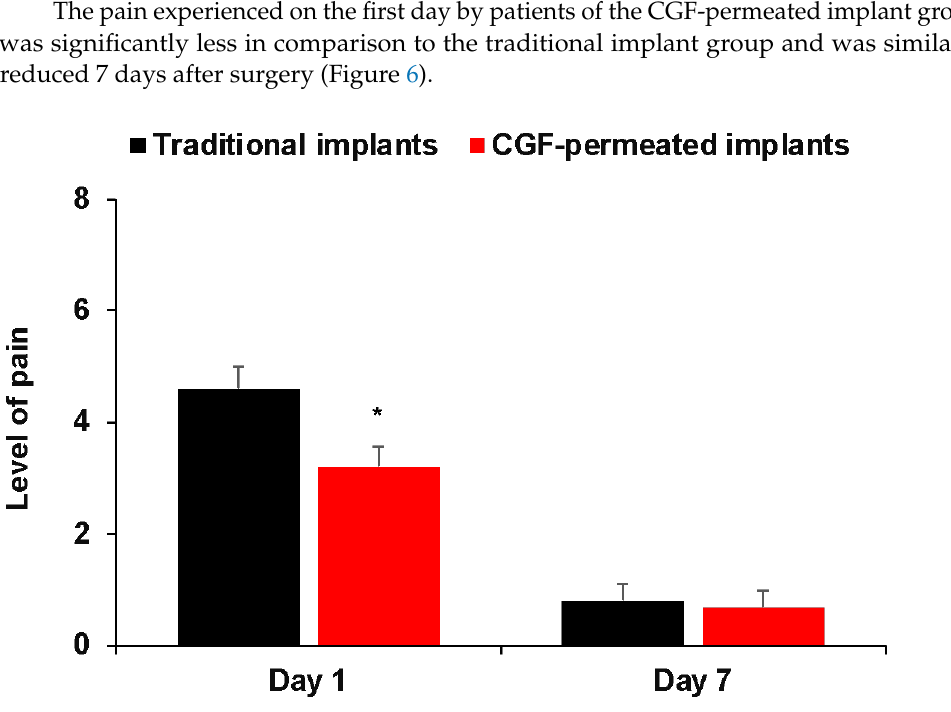
Figure 6. Post-operative level of pain between two groups (traditional implants and CGF-permeated implants) at different time points. * p < 0.05 versus traditional implants.